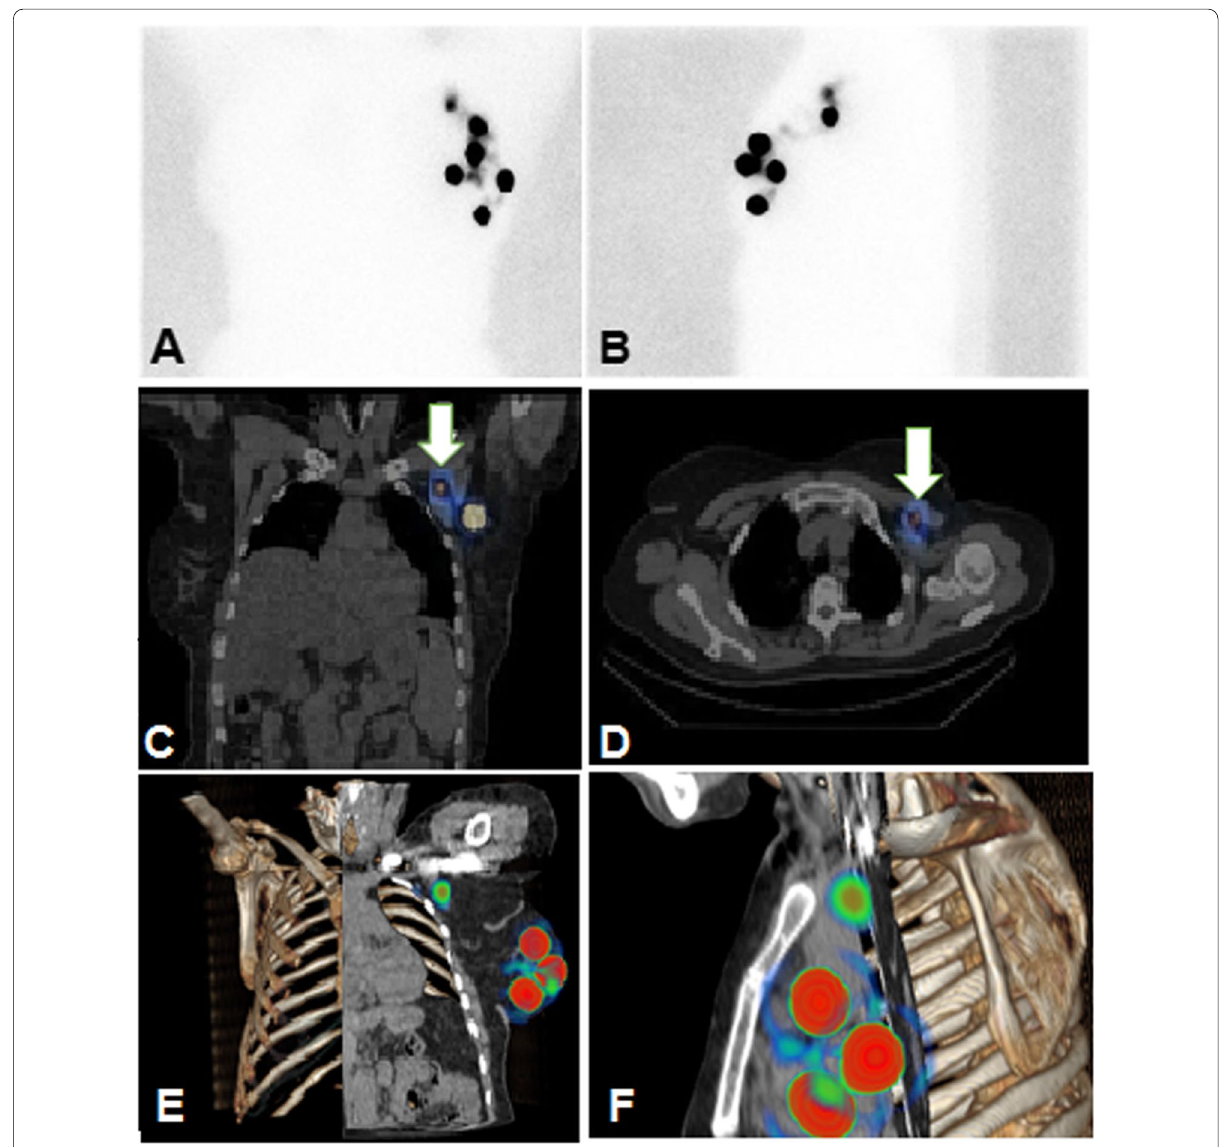
Fig. 1 48-year-old female with invasive ductal carcinoma of the left breast. A , B PS demonstrating activity within multiple lymphatic channels. Two hot left axillary nodes are noted. C – F The fused SPECT/CT images pinpoints the level-I left axillary node. The medial focus (arrow) turned to be a left Interpectoral lymph node (Rotter’s